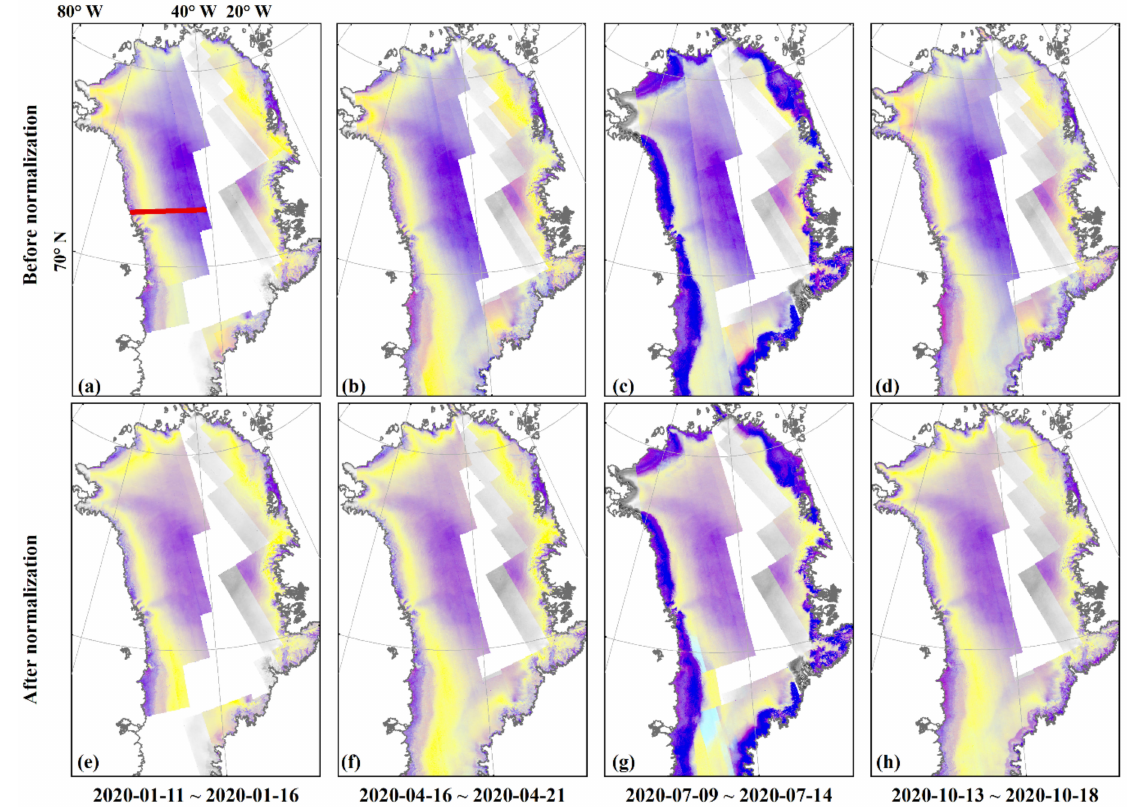
Figure 7. Sentinel-1 mosaics of the GrIS images before ( a – d ) and after ( e – h ) incidence angle normal- ization by the incidence angle correction method. The mosaics are RGB pseudo-color composite images, R: HH, G: HV, B: HH/HV (all in dB values). EW1 of the HV images was